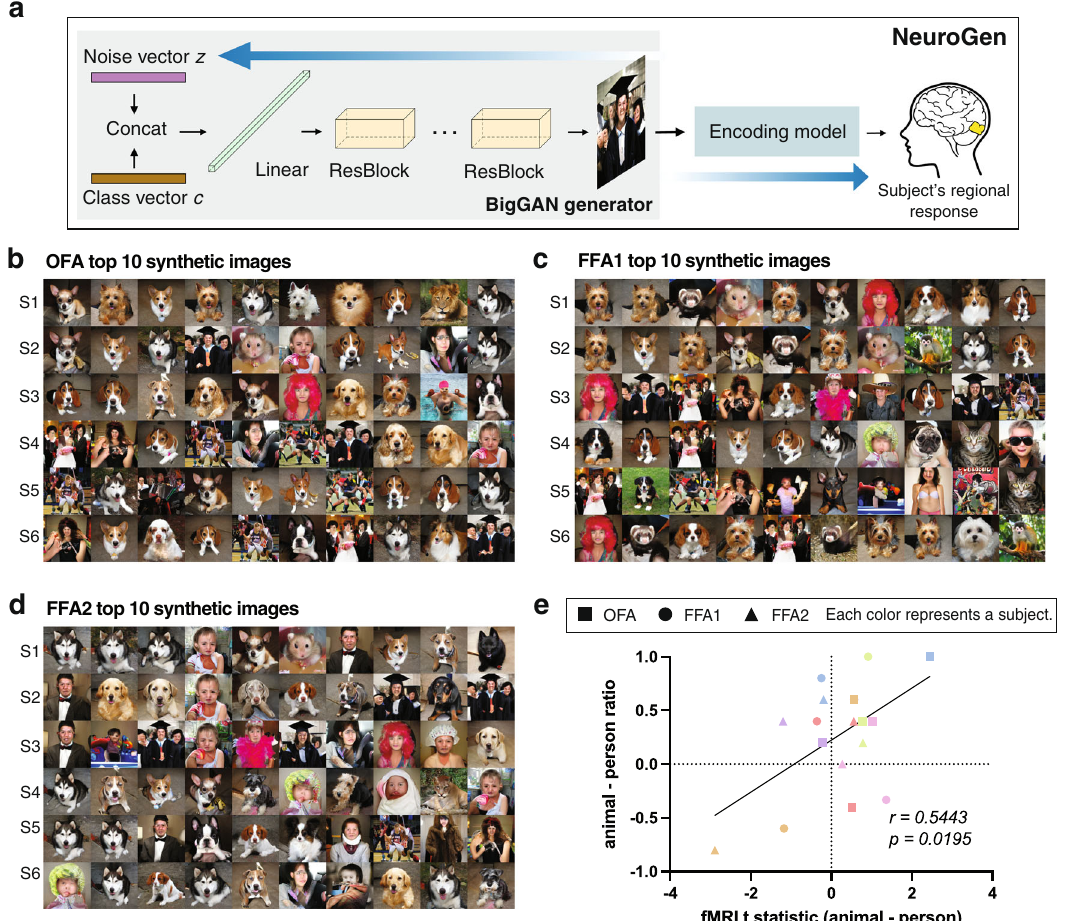
Fig. 5 Linear ensemble models capture individual regional preferences in NeuroGen framework. a The NeuroGen framework concatenates a image generator (BigGAN) with an encoding model to synthesize images that achieve a desired predicted response in one or more brain regions. One synthetic image is generated from a 1000 dimension, one-hot encoded class vector (corresponding to one class in ImageNet) and a noise vector, which will be identi fi ed through optimization Different synthetic images may have different class vectors. The output image is then fed into the encoding model to obtain a region ’ s predicted response for that image. b – d Synthetic images from the version of NeuroGen using the linear ensemble encoding model; the 10 images were designed to maximize activation for each of the six NeuroGen individuals (one individual per row) in OFA, FFA1 and FFA2 regions, respectively. e A scatter plot indicating for each of the 3 face regions for each of the six NeuroGen individuals, the observed t-statistic of OFA, FFA1, and FFA2 ’ s responses to images of animal versus human faces ( x -axis) and the ratio of the number of animal images minus the number of human images, divided by the sum of these two numbers, out of their top 10 synthetic images created via NeuroGen ( y -axis). Each color represents a subject and each shape represents a different face